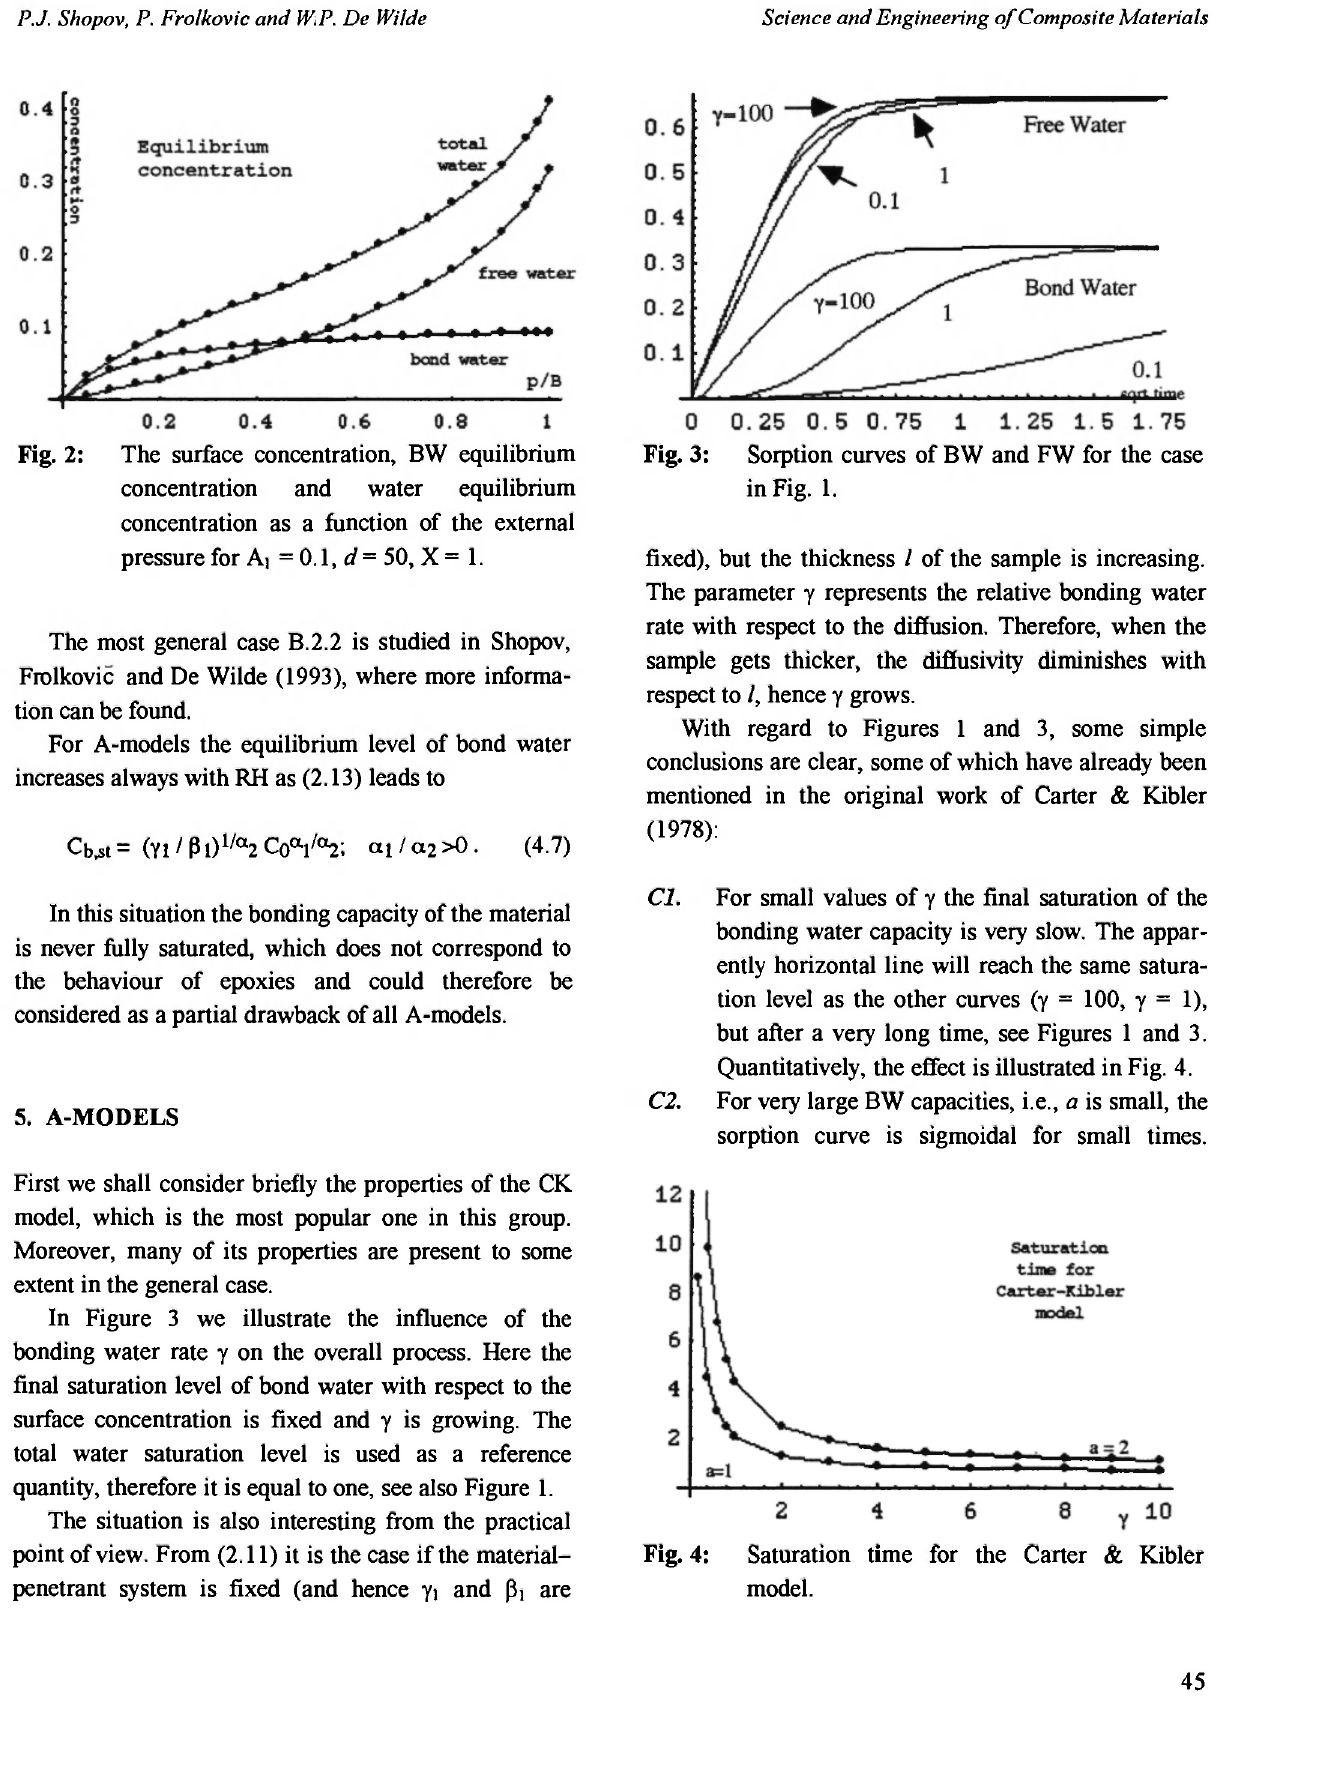
Fig. 3: Sorption curves of BW and FW for the case in Fig. 1.